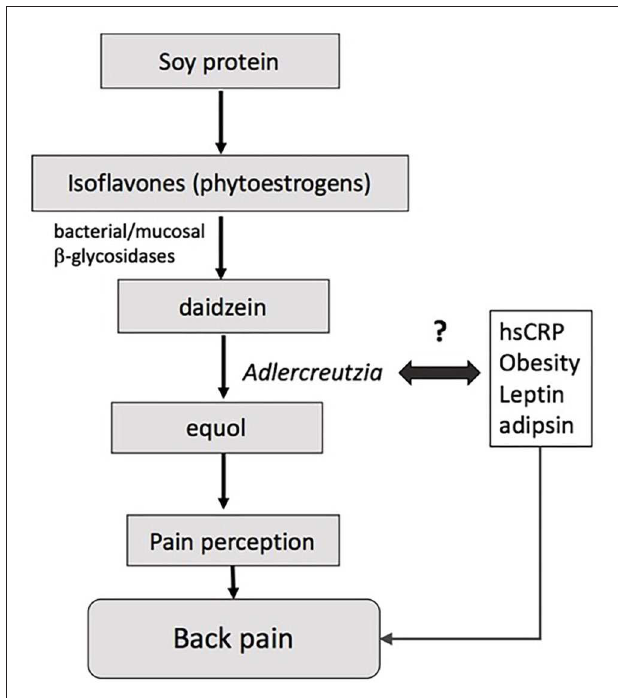
FIGURE 3 | Model for how Adlercreutzia may influence back